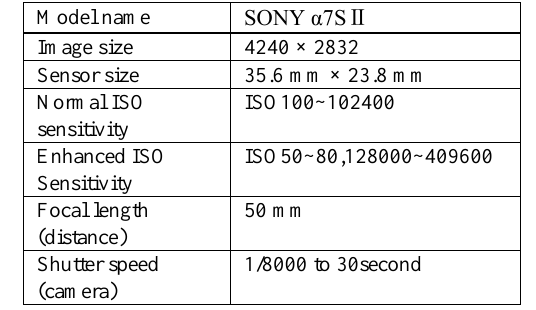
Figure 2 . Brightness distribution of irradiation.